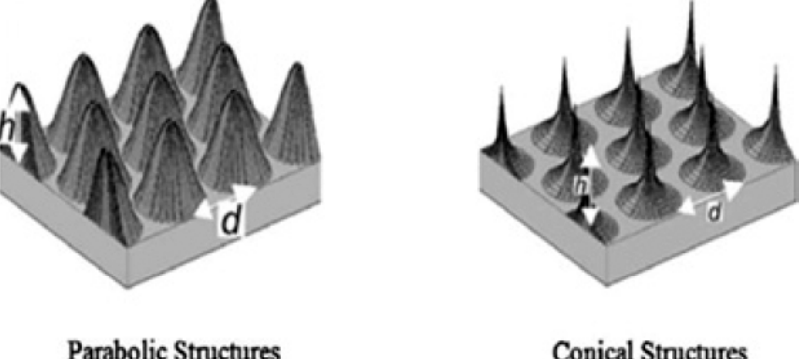
Fig. 7. Gaussian-bell shape, conical, and paraboloidal on the cornea of amber. Reprinted with permission from S. A. Boden and D. M. Bagnall // Applied Physics Letters 93 (2008)